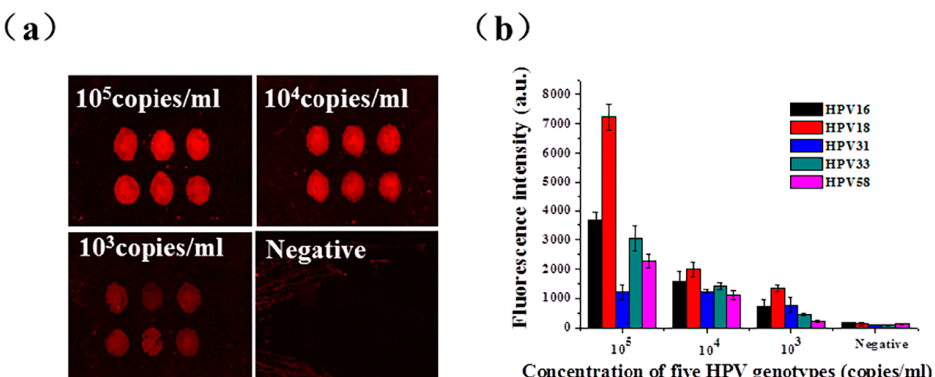
Figure 4. The sensitivity of the integrated chip for the detection of the five positive control HPV genotypes. ( a ) The fluorescence intensities of the different concentrations obtained by gradient dilution of the positive control sample HPV31 on the integrated chip for DNA extraction and SP-PCR. ( b ) Serial 10-fold dilutions of the five positive HPV genotypes at specific concentrations were used as templates for on-chip DNA extraction and SP-PCR.